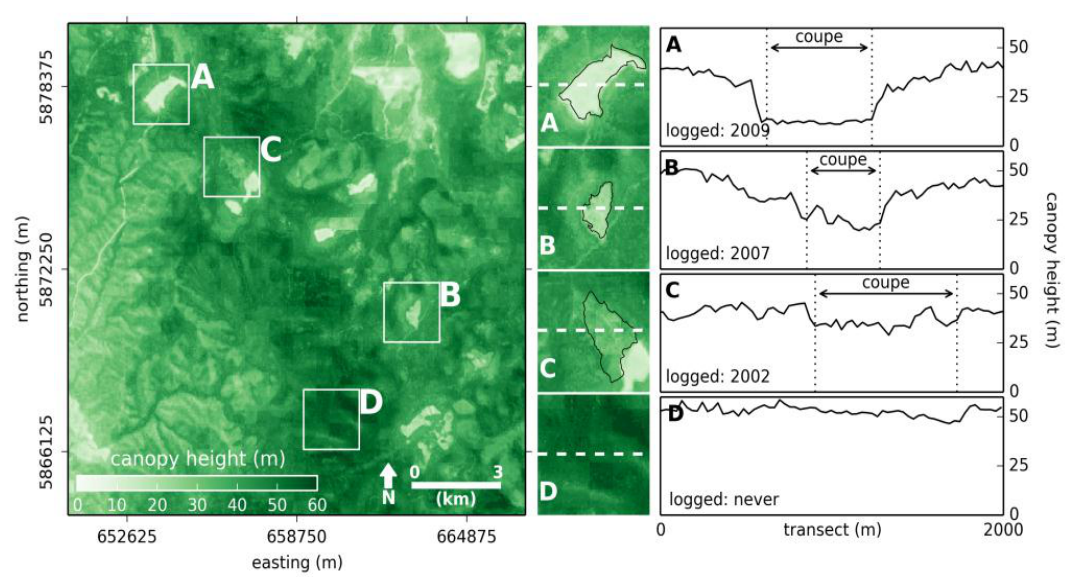
Figure 6. A map of canopy height (30 m resolution) for an area of 16.5 km × 16.5 km, highlighting the land use history of an area of mixed-use forest ( left ). Three logging coupes that were clear-felled between 2002 and 2009 ( A – C ) and an area that has never been logged ( D ) are singled out (coupe extents outlined in black) (center column). Transects of canopy height across each coupe indicating regrowth since logging, coupe boundaries are also identified ( right ). Coordinate system is the projected Map Grid of Australia (MGA) zone